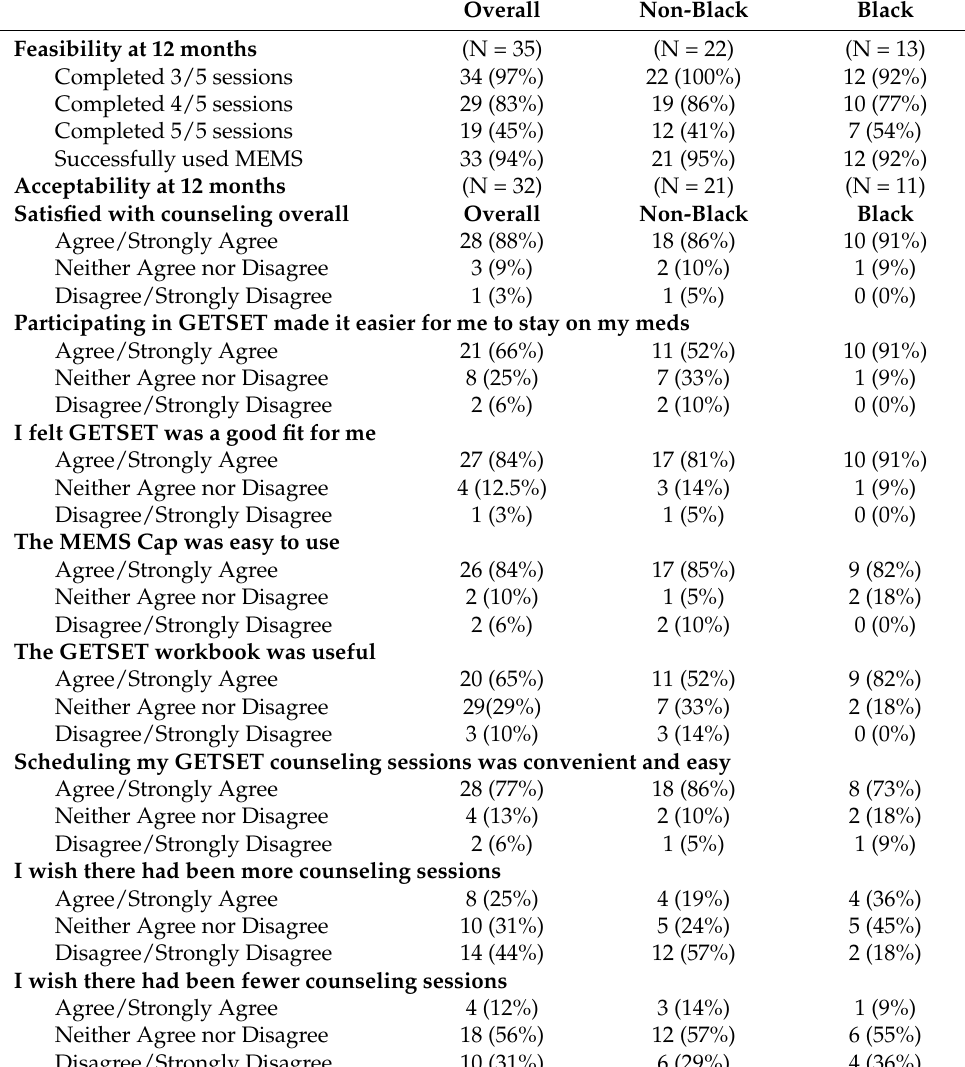
Table A2. GETSET feasibility and acceptability outcomes by